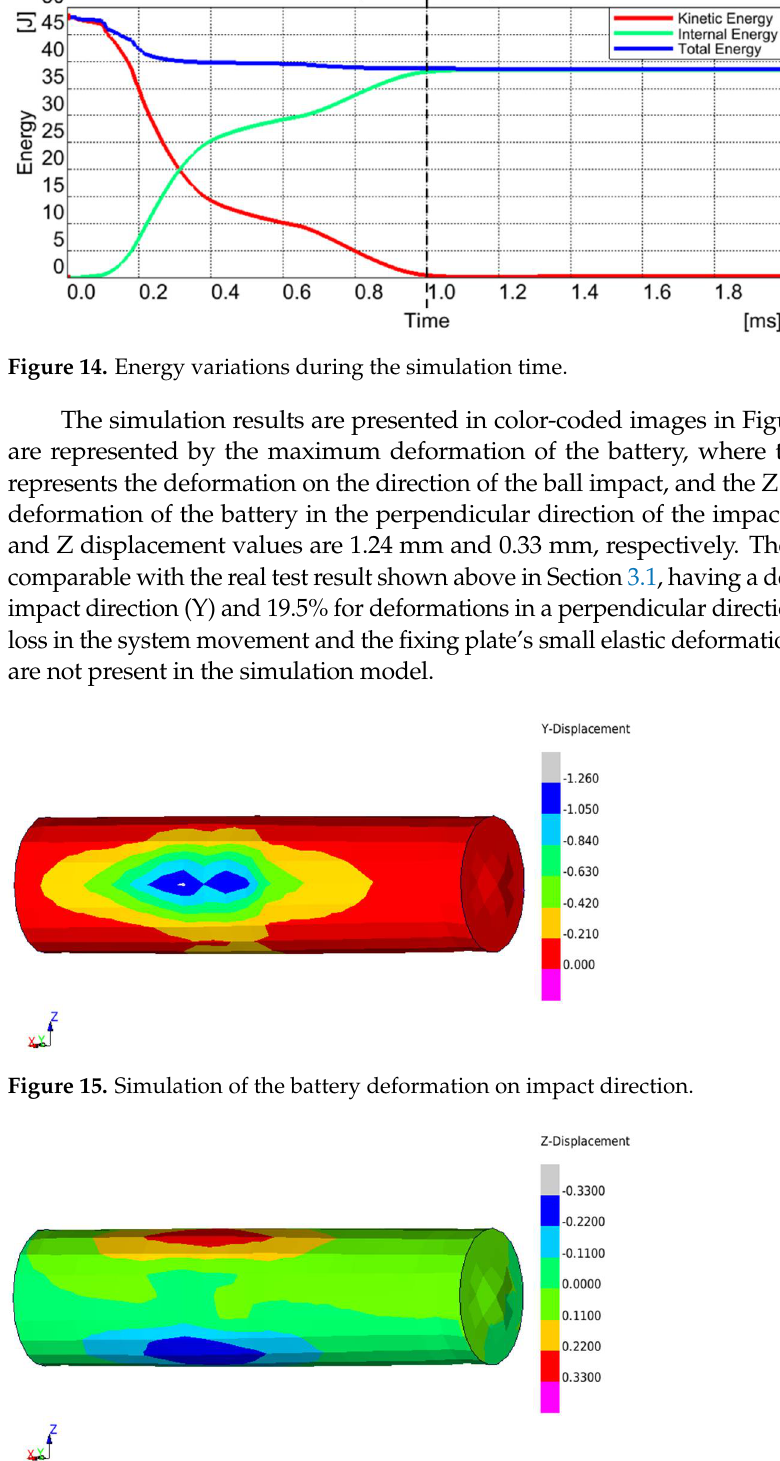
( b ) Figure 13. Simulation of the battery: ( a ) layout side view of the initial state and ( b ) last state of the simulation. In an explicit simulation, the important energy check is related to the variation of the kinetic, internal, and total energy. Figure 14 represents the energy variations across the simulation time, during which the kinetic energy value at the beginning of simulation was 48 J, the same as the kinetic energy of the real test calculated in the second paragraph. We